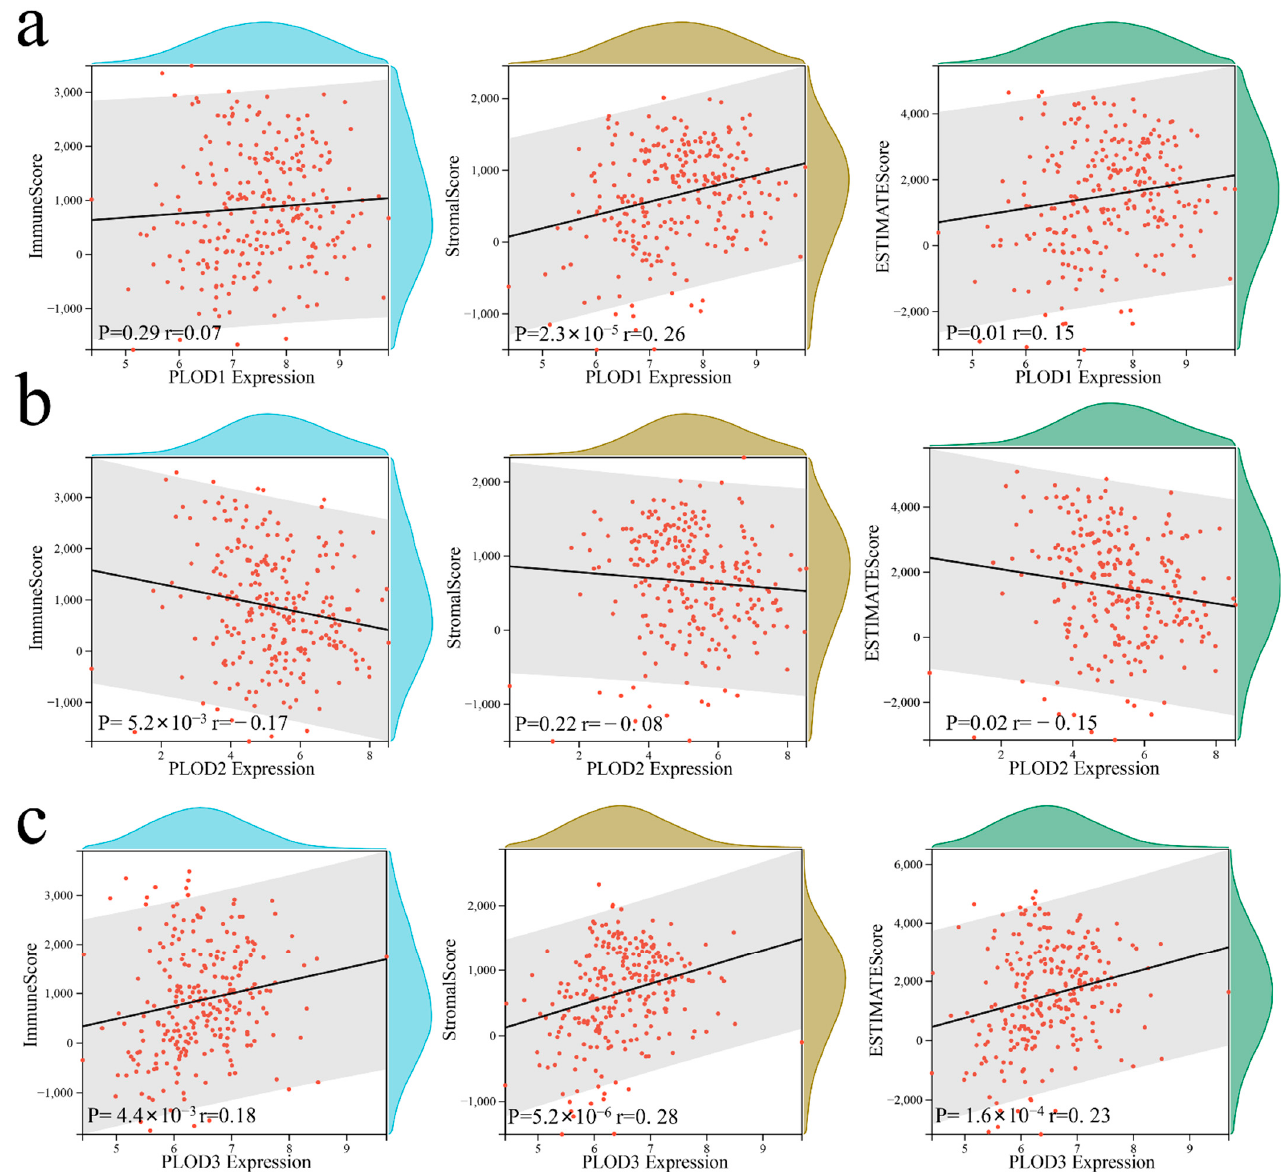
Figure 7. The overview of PLOD family members’ correlation with ImmuneScore, StromaScore, and ESTIMATEScore. ( a ) PLOD1, ( b ) PLOD2, and ( c ) PLOD3.